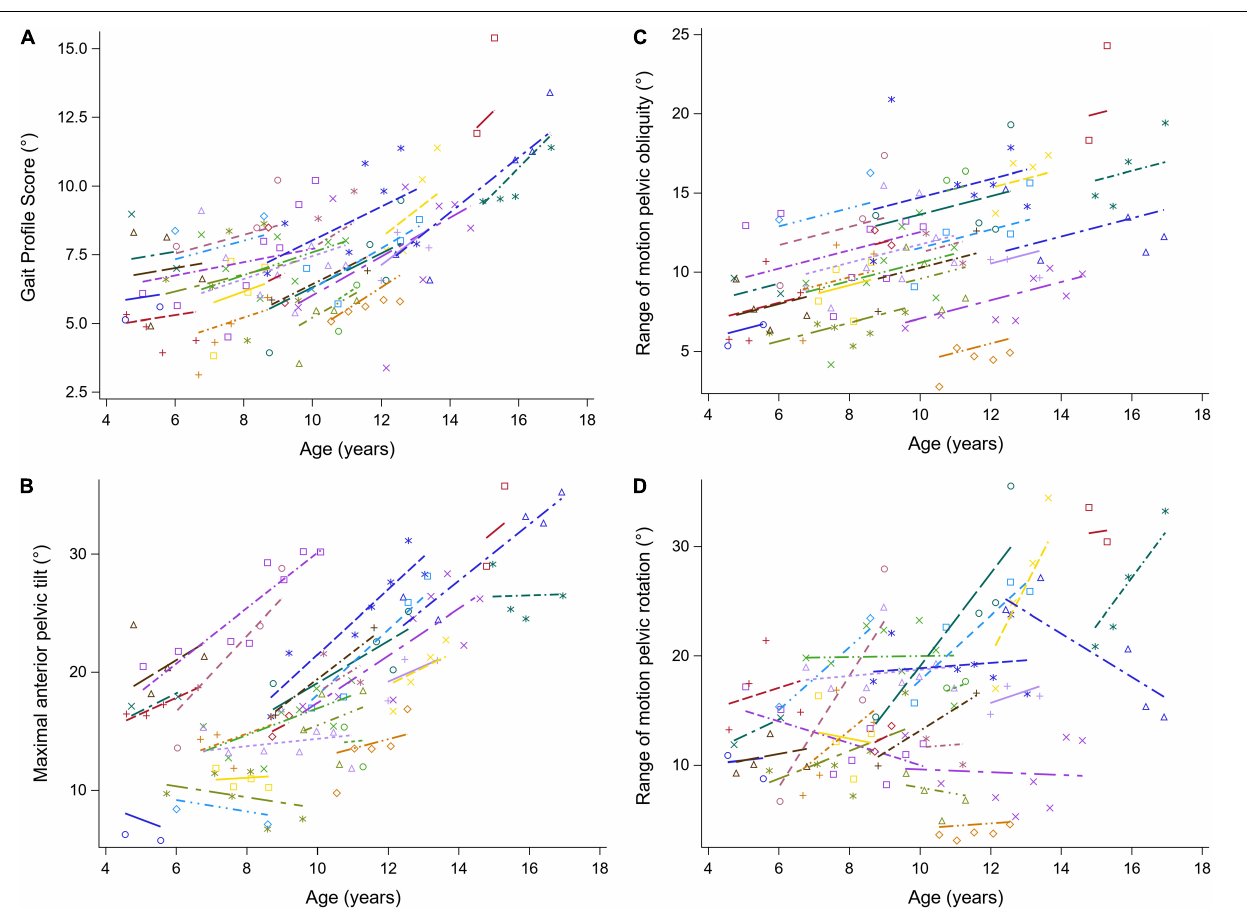
FIGURE 4 | The individual predicted profiles (dashed lines) for the GPS (A) , the maximal anterior pelvic tilt (B) , range of motion pelvic obliquity (C) , and range of motion pelvic rotation (D) . The actual observed values are visualized by the symbols. Each color represents one patient with DMD. The regression coefficients of the fixed effects are given in Table 4 . DMD, Duchenne muscular dystrophy; GPS, Gait Profile